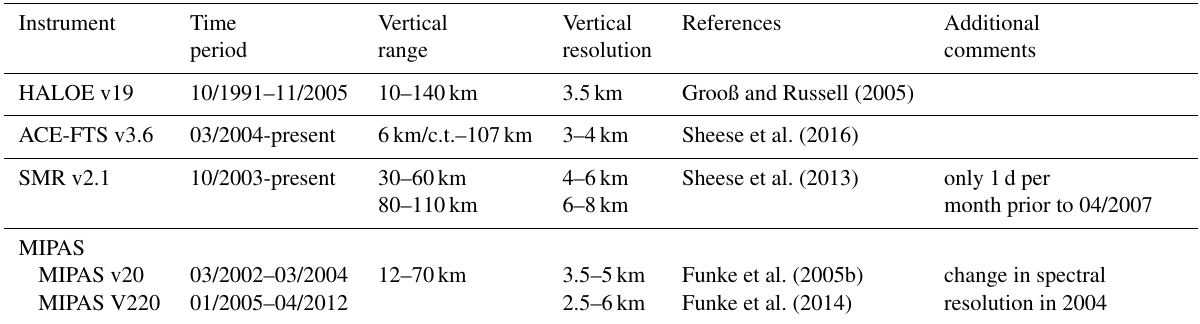
Table 13. Time period, vertical range, vertical resolution, references, and other comments for NO measurements. Note that c.t. refers to cloud top in this table.